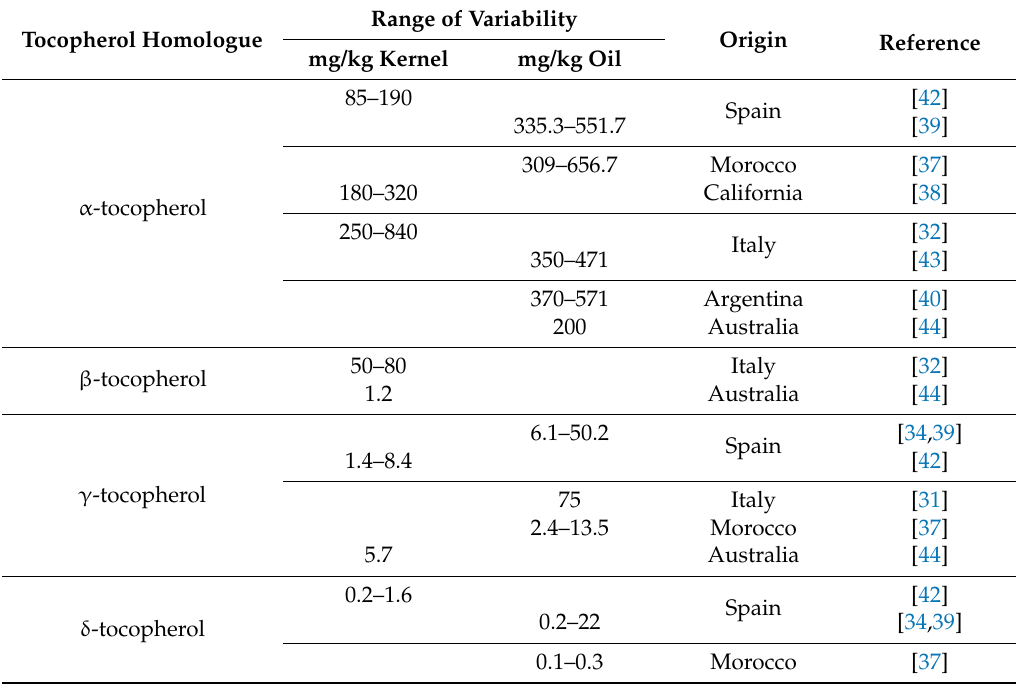
Table 1. Tocopherol homologue concentration in almond kernel and kernel